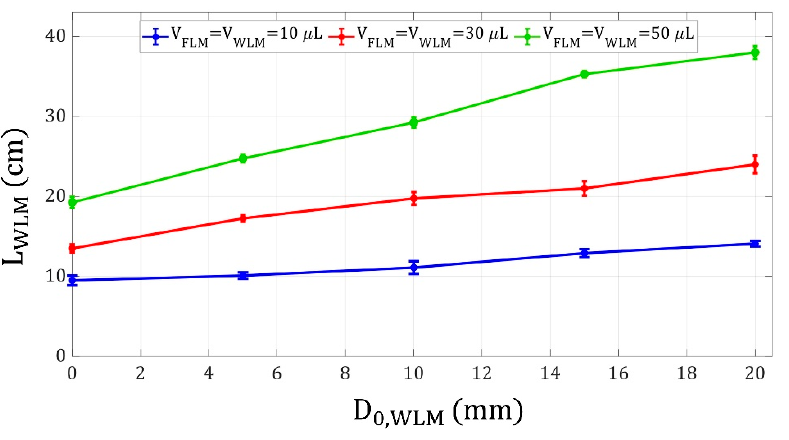
Figure 6. WLM shooting distance versus WLM initial distance from the electromagnet for liquid marble volumes of 10, 30, and 50 μ L, FLM initial distance of 30 mm from the electromagnet, and coil current of 3 A.